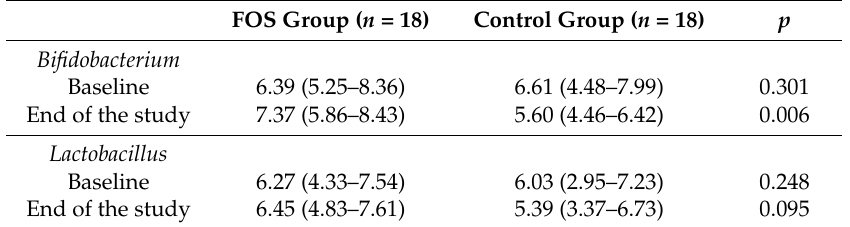
Table 3. Secondary outcome: Bifidobacterium and Lactobacillus genus counts (log